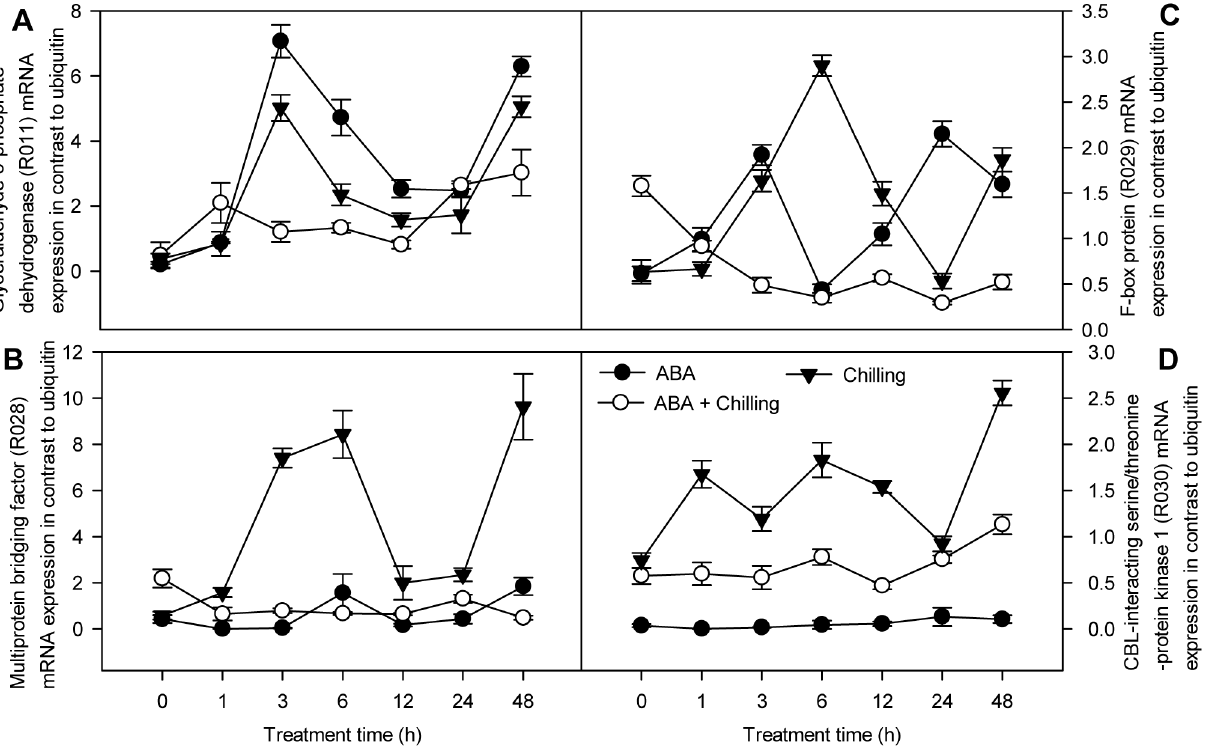
Figure 6. Analysis of mRNA expression using qPCR of four genes found downregulated with SSH. Total RNA was extracted from pepper leaves with ABA spray or water, subsequently 72 h after foliar application exposed for 48 h to 6 u C. SE was calculated based on three biological replicates. Closed circle: ABA-pretreated samples under room temperature; open circle: ABA-sprayed samples prior to chilling stress; triangle down: water-sprayed samples prior to chilling stress. The level of ubiquitin was used as an internal reference gene.